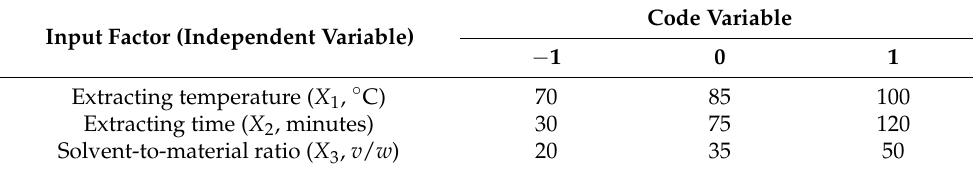
Table 4. The conversion between code variables and reality variables.